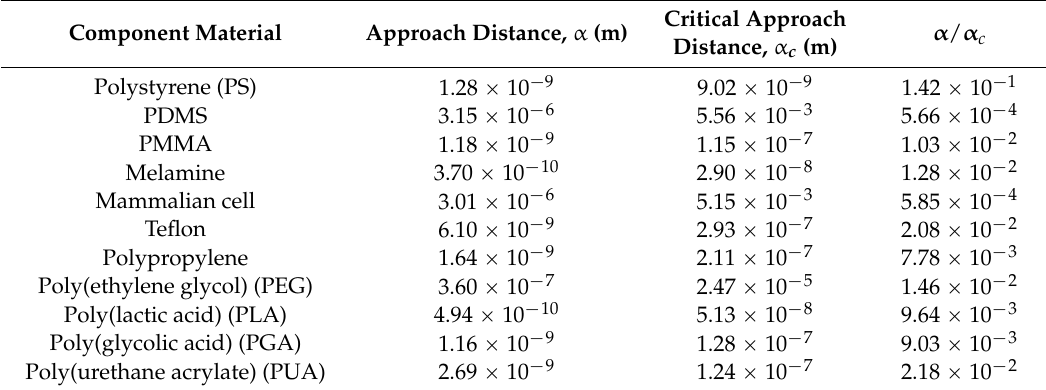
Table 2. Approach distance calculated on a flat surface and comparison with critical approach values. Calculations assume a cylindrical microcomponent with diameter of 26 µ m and a contact length of 50 µ m and an applied contact load of 3.4 ˆ 10 ´ 5